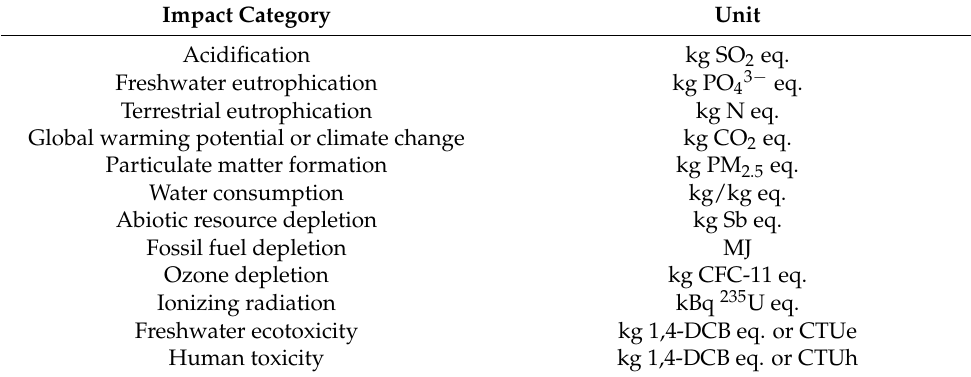
Table 1. Categories of potential environmental and social impacts used in LCIA. Impact Category Unit